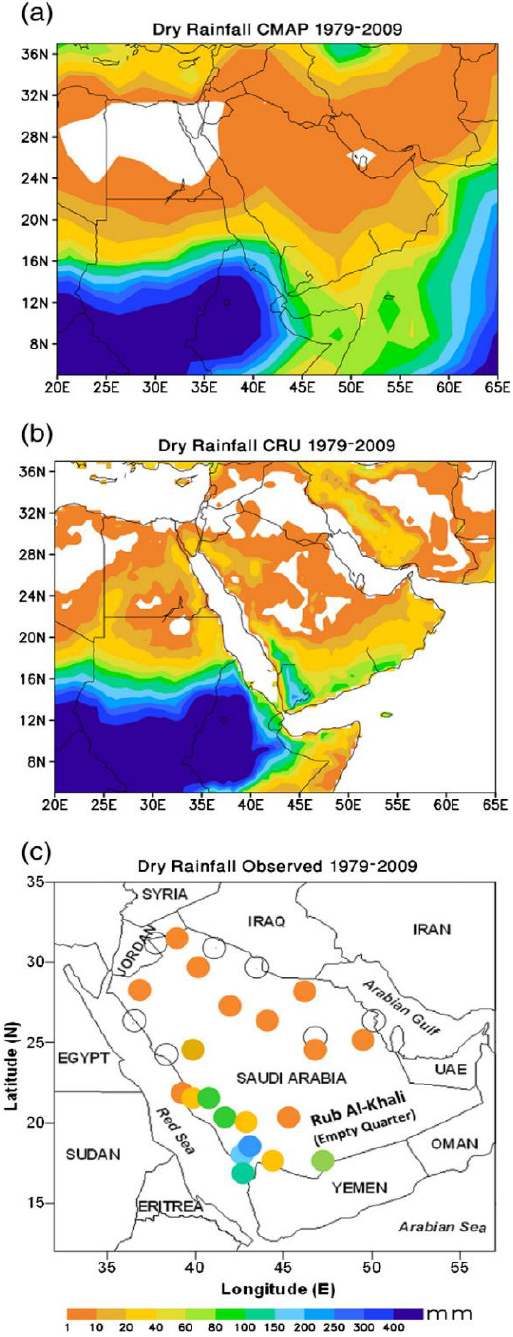
Figure 3. Spatial distribution of the dry season rainfall (mm) averaged for the period 1979–2009 obtained from the ( a ) CMAP, ( b ) CRU, and ( c ) station datasets. In panel ( c ), the open circles indicate rainfall amounts less than 1 mm